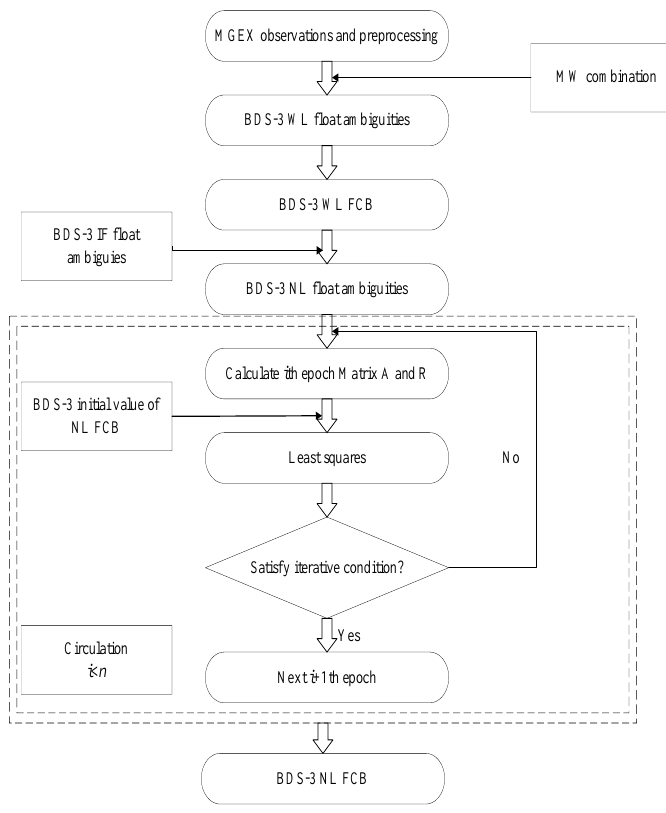
Figure 1. Flowchart of the traditional BDS-3 FCB method of estimation.